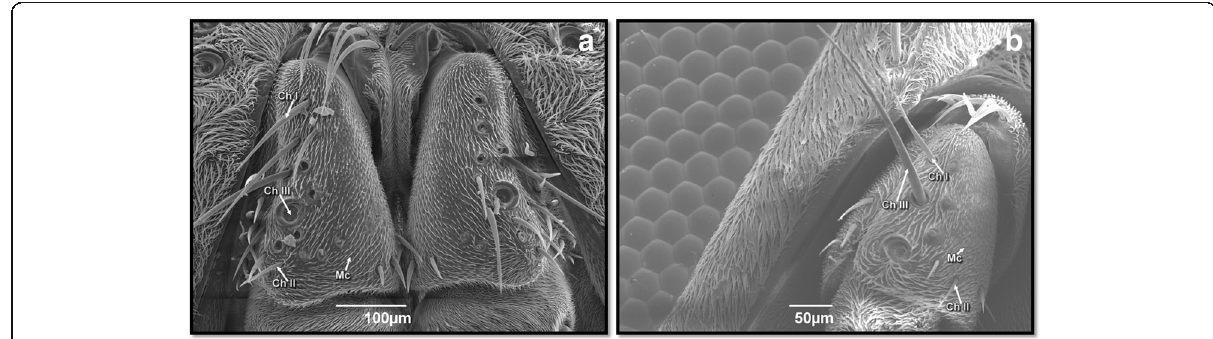
Fig. 6 Scanning electron micrographs showing the cuticular surface of pedicel in both genders of Mesembrinella bicolor : a female (× 220), b male (× 270). Pe = pedicel; ChI-ChIII = chaetic sensilla I, II and III; Mc =